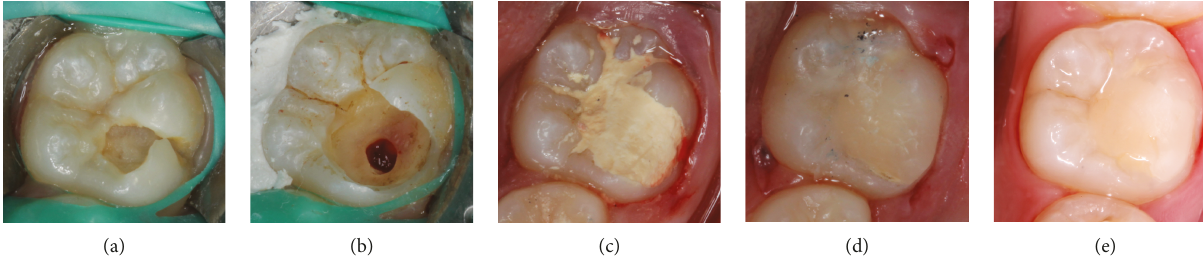
Figure 1: Intraoral photographs: (a) initial clinical appearance, (b) after pulp tissue removal and haemorrhage was controlled, (c) Biodentine ™ was placed as a temporary fi lling, (d) restored with composite resin, and (e) colour stability of the tooth after a fi ve-year follow-up.